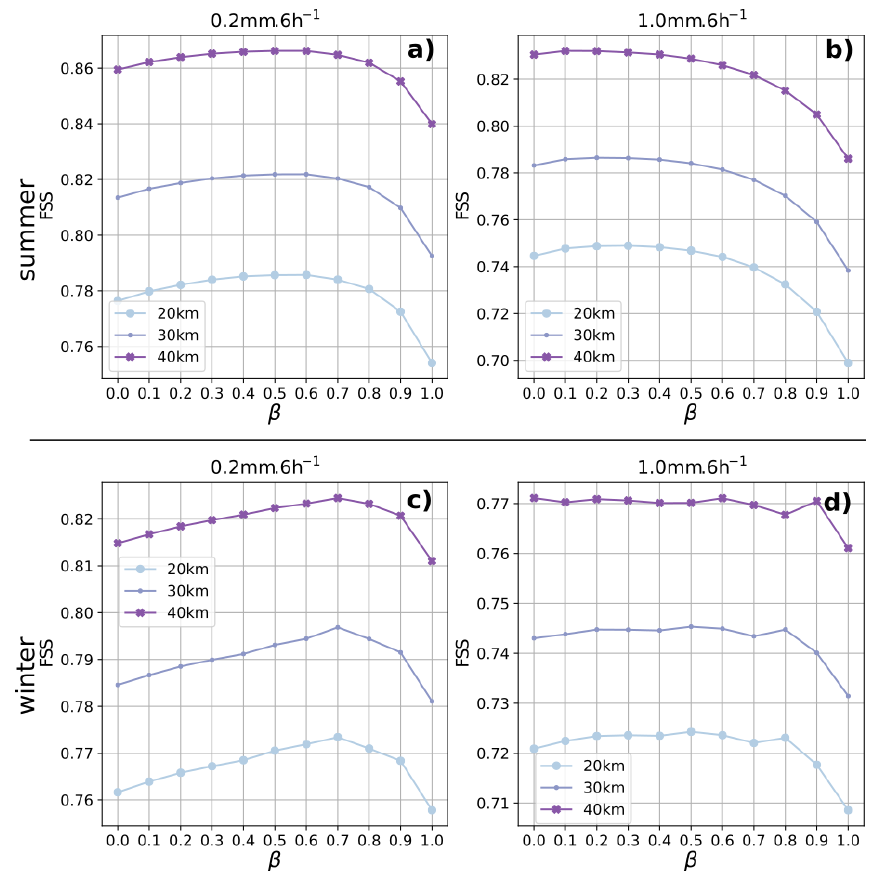
Figure 7. The fraction skill score (FSS) as a function of the different β values for the 6h precipitation meeting or exceeding the 0.2mm (a, c) and 1.0mm (b, d) thresholds for summer (a, b) and winter (c, d) , using ST4 precipitation as reference. Each curve represents a different neighboring length scale (20, 30, or